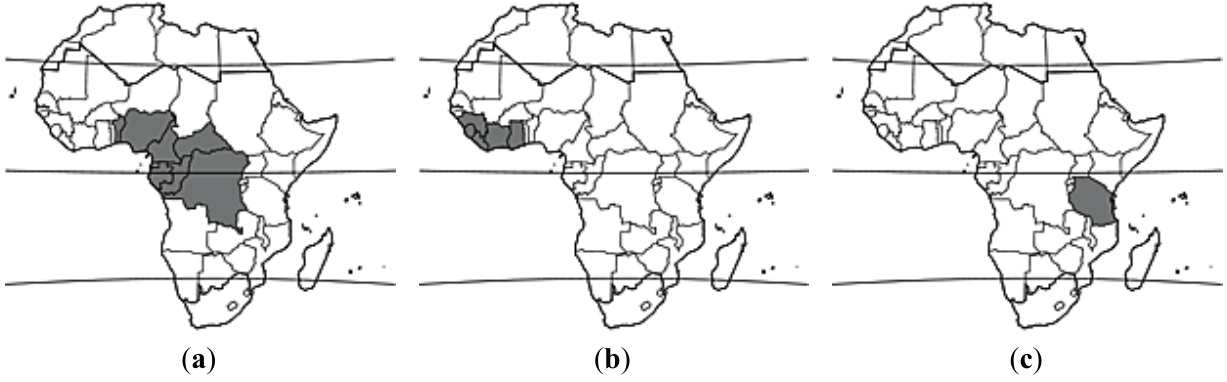
Figure 1. Native geographic distributions of ( a ) Allanblackia floribunda ; ( b ) A. parviflora ; and ( c ) A. stuhlmannii . Maps reprinted with permission from: PROTA (Plant Resources of Tropical Africa/Ressources végétales de l’Afrique tropicale), Wageningen, The Netherlands.